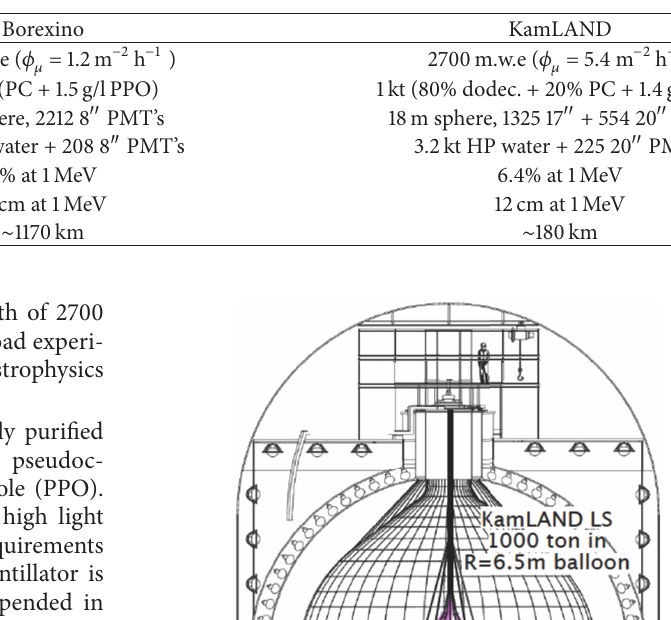
Figure 2: The map of six 2 ∘ × 2 ∘ tiles from which the LOC geoneutrino signal (see Table 1) is calculated for the Borexino ((a), from [39]) and KamLAND ((b), from [40]) sites. Table 2: Main characteristics of the Borexino and KamLAND detectors.